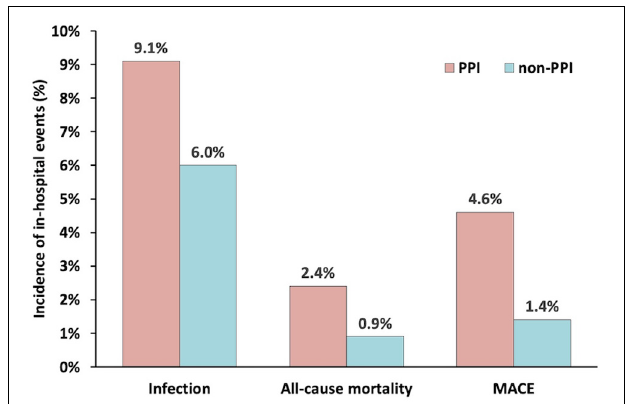
FIGURE 2 | The incidence of infection, all-cause mortality, and major adverse clinical events during hospitalization in the propensity score matched groups.